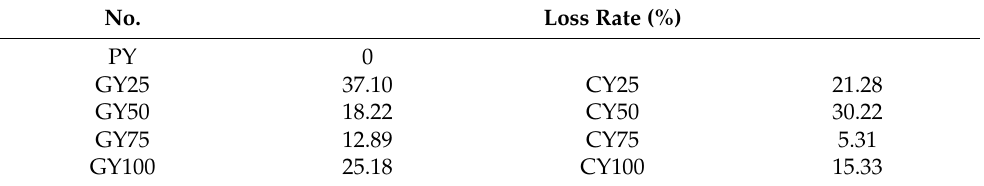
Table 7. Compressive strength loss rate of grouted steel ball concrete with different